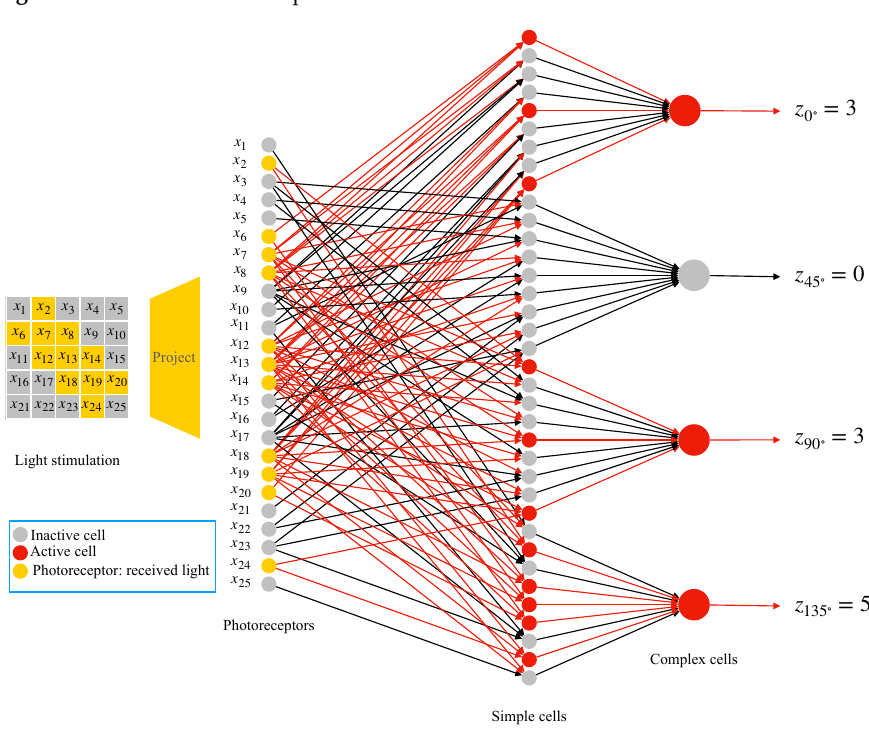
Figure 10. The structure of AVS used on detecting a 5 × 5 image. Effective neural connections and active cells are colored red. Photoreceptors received light are colored